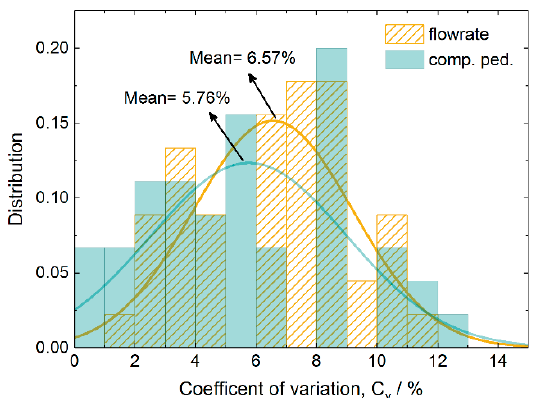
Figure 11. Distributions of variation coefficient for the considered cases with various checking failure probabilities and delay times in terms of total flowrate and competitive pedestrian-time. The lines are the corresponding Gaussian distributions.